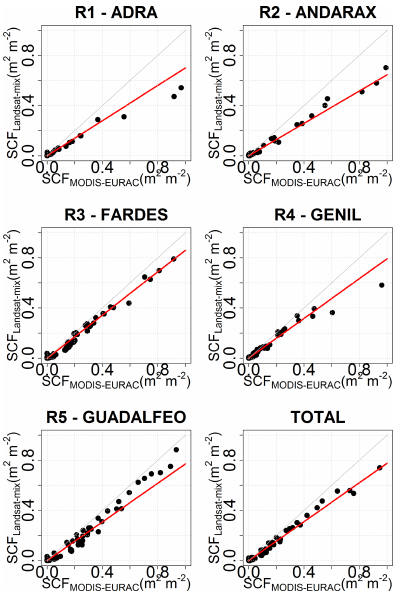
Figure 3. Dispersion graphs comparing both products MODIS- EURAC ( x -axis) and Landsat-mix ( y -axis) in the 108 selected dates along the study period. Linear fit defined following Eq. (1) and the parameters of Table 1 (red line). 1 : 1 line in light grey. Table 1. Fitted parameters and coefficient of determination ( a , b and R 2 ) of the linear model that related both products, MODIS- EURAC and Landsat-mix in each of the region and in the whole study